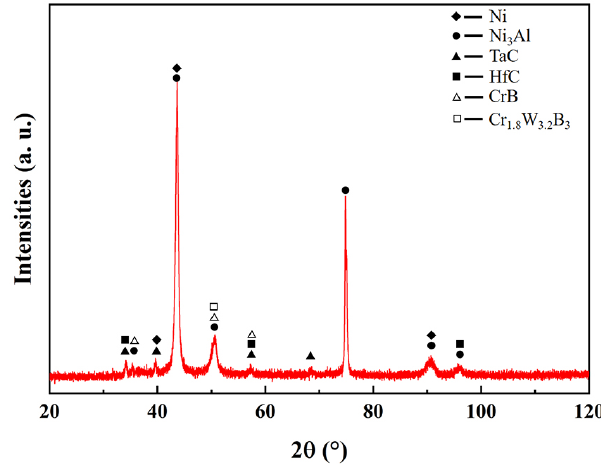
Figure 7. XRD pattern of TLP-diffusion-bonded joint using low-B interlayer XRD.